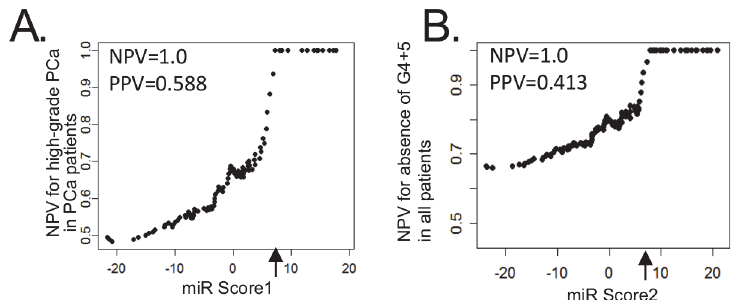
Fig 2. Circulating miRNAs predict absence of high-grade disease. A, negative predictive value (NPV, y- axis) for absence of Gleason 4 +5 in the PCa patients only (N = 100) across the range of miR Score1 (x-axis) reaching NPV = 1 at the miR Score1 threshold of 7.19 (arrow). B , NPV reaches 1 for absence of Gleason 4+5 in entire cohort (BPH, low-grade PCa, high-grade PCa) at the miR Score2 threshold of 7.85 (arrow). The equations for the miR Scores, inwhich themiRNA name represents thelog2RQ value: miR Score1 = (0.269x let-7a) + (0.257x miR-103) + (0.254x miR-451) + (0.255 x miR-24) + (0.252x miR-26b) + (0.255x miR-30c) + (0.221 x miR-93) + (0.253x miR-106a) + (0.274 x miR-223) + (0.188 x miR-874) + (0.200 x miR-146a) + (0.118x miR-100) + (0.276 x miR-107) + (0.204 x miR-130b). miR Score2 = (0.289x levelLet7a) + (0.286 x levelmiR- 103) + (0.308 x level miR-451) + (0.267 x level miR-24) + (0.256 x level miR-26b) + (0.282 x level miR-30c) + (0.231 x level miR-93) + (0.263x levelmiR-106a) + (0.293 x level miR-223) + (0.161 x level miR-874) + (0.227